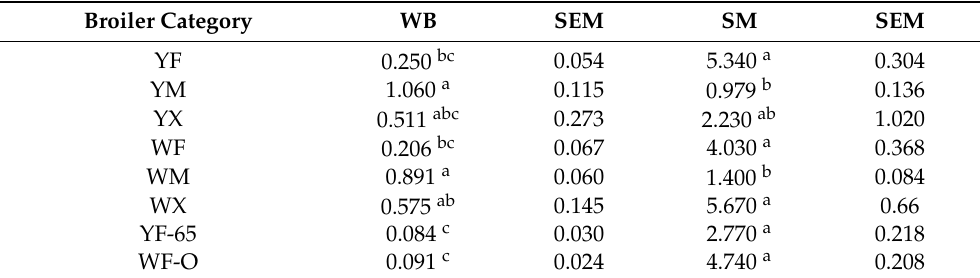
Table 3. Incidence of WB and SM (expressed as a percentage) for each category of broiler (means adjusted by least squares in the natural transformed